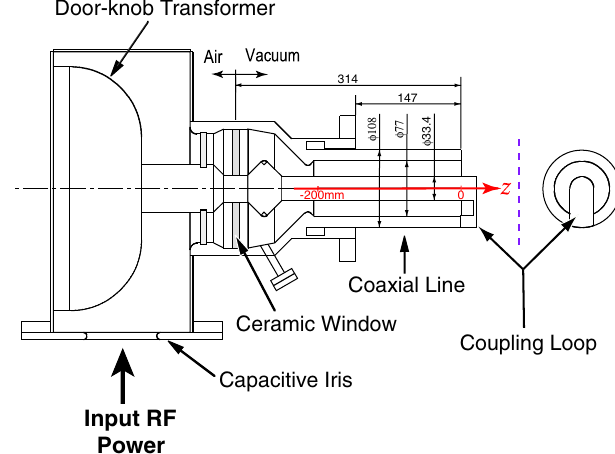
FIG. 1. (Color) Schematic drawing of the ARES input coupler. The z axis used in the multipactoring simulation is shown as a horizontal arrow. The vertical dashed line indicates the position of the effective reflection plane explained in the text.*Electronic address: